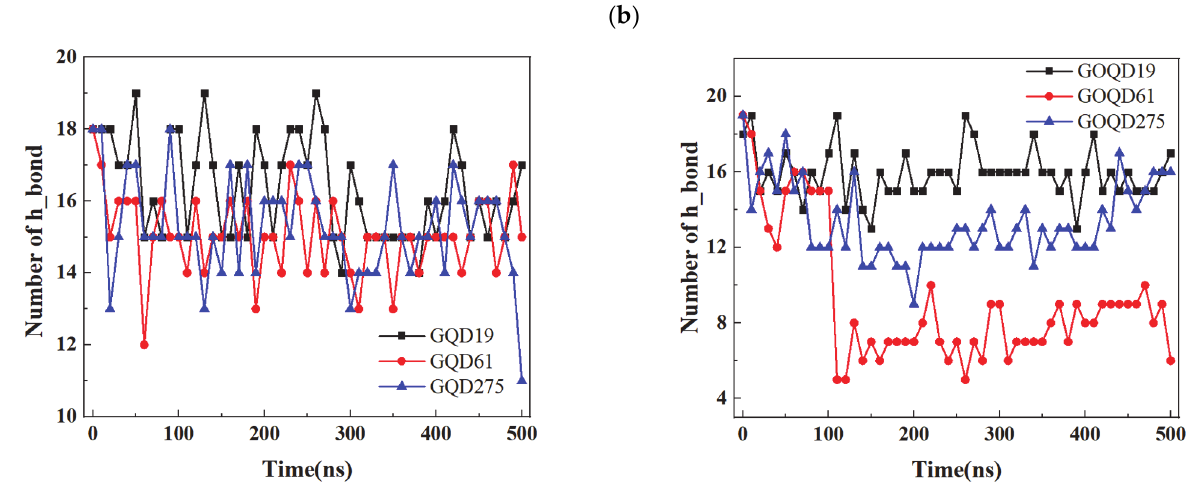
Figure 8. ( a ) The number of hydrogen bonds between the base pairs of dsDNA and GQDs with different sizes during the simulation. ( b ) The number of hydrogen bonds between the base pairs of dsDNA and GOQDs with different sizes during the simulation.